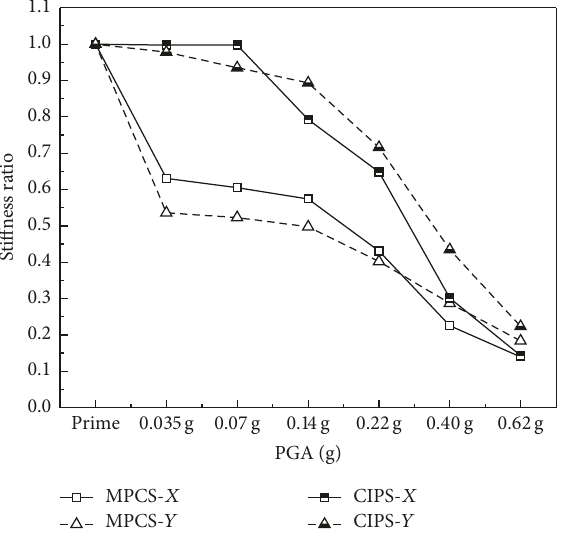
Figure 7: Stiffness ratio versus frequency in 𝑋 and 𝑌